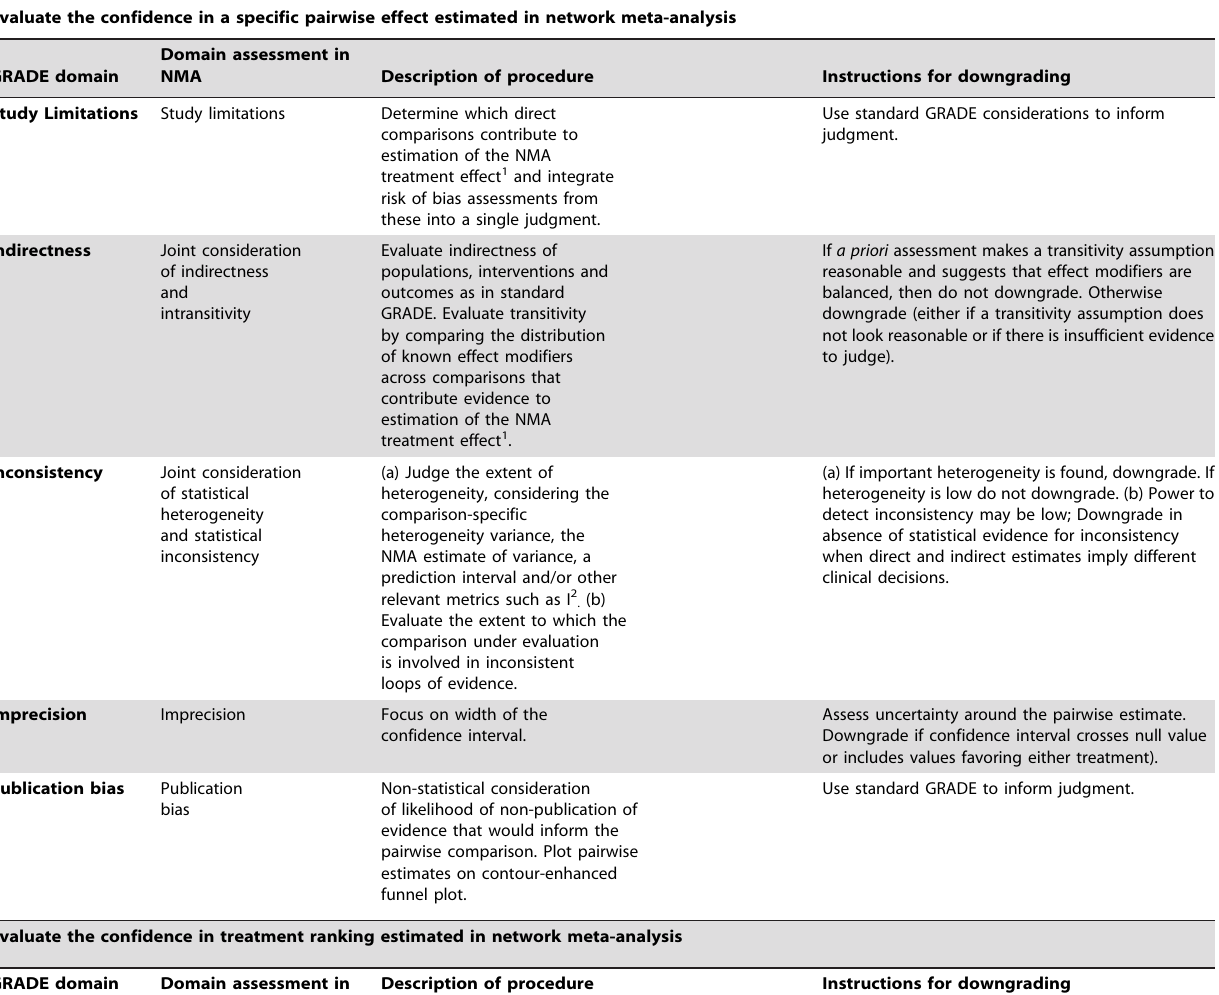
Table 3. Summary of domain assessment for evaluating the quality of evidence from a network meta-analysis: Procedures for a pairwise effect estimate and overall